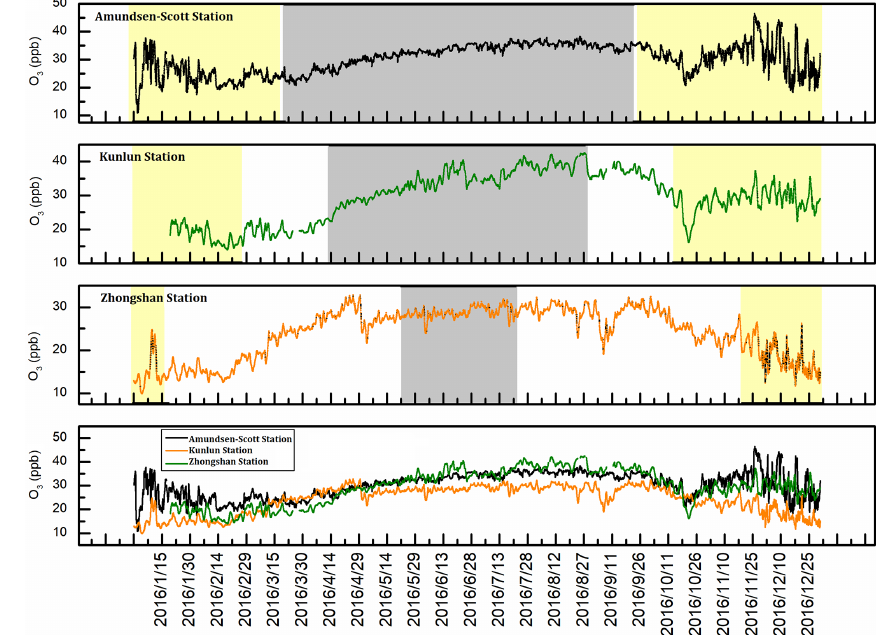
Figure 2. Time series of near-surface O 3 at SP, DA and ZS during 2016. Yellow (gray) shading identifies the polar day (night).